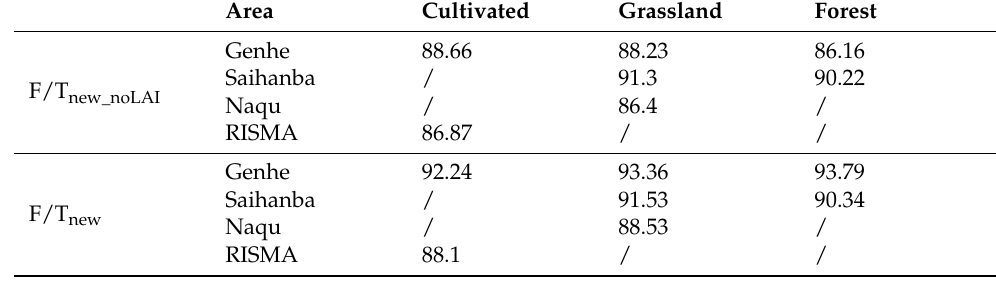
Figure 20. The frozen days of F/T new ( a ) and F/T new_noLAI ( b ) from June 2017 to May 2018 over the Genhe watershed area as an example.